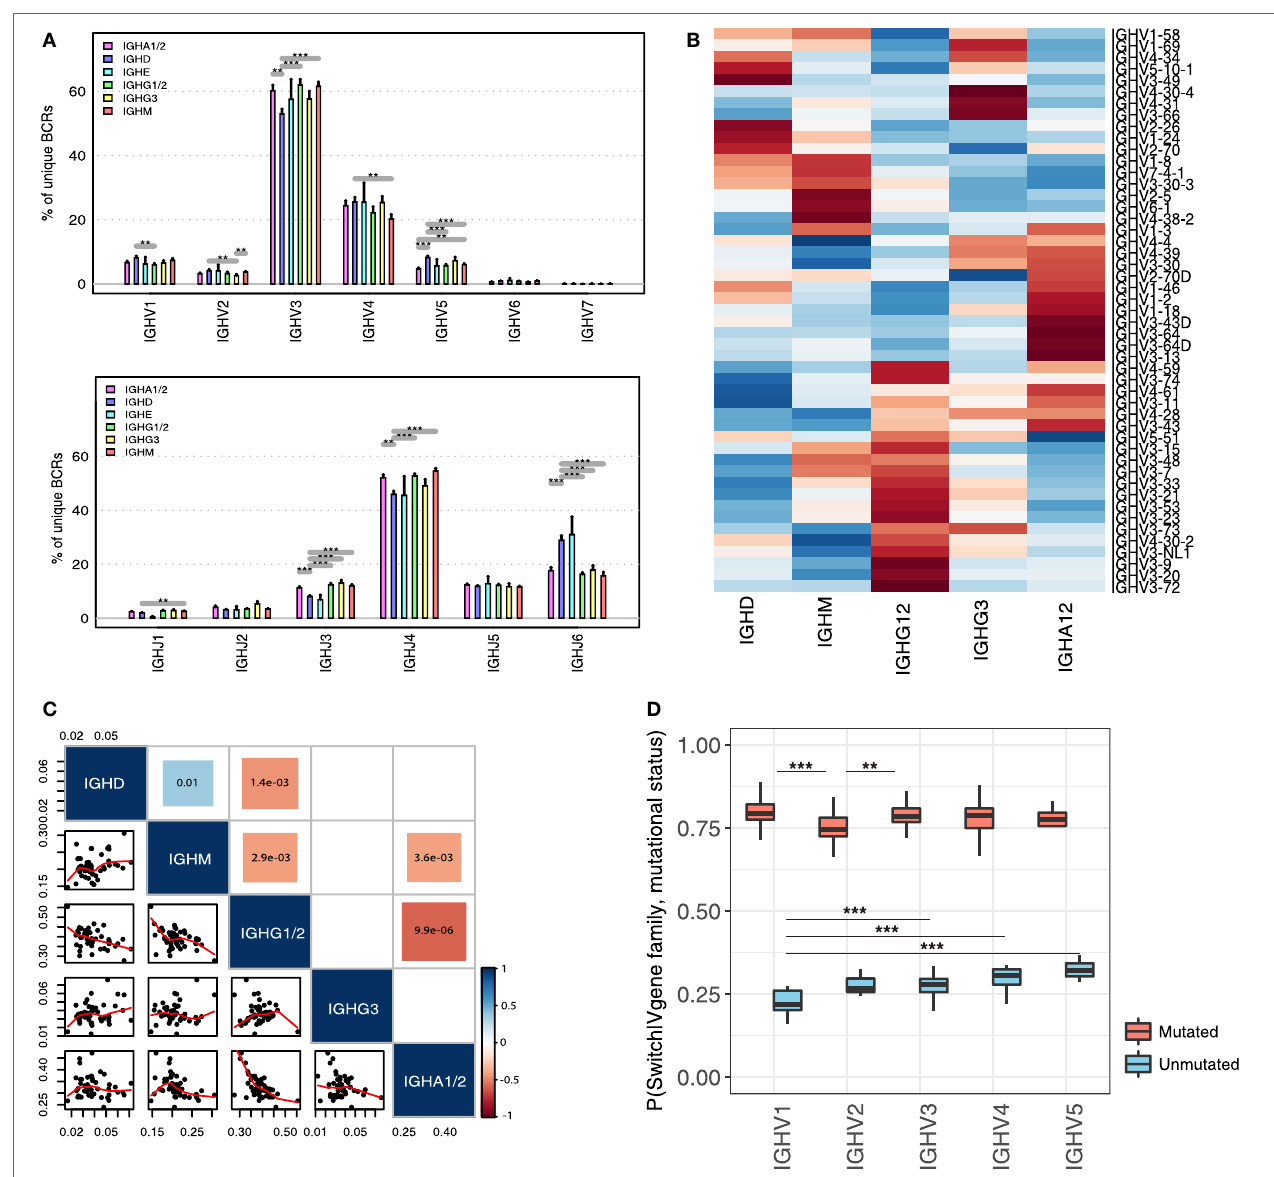
FigUre 5 | Role of somatic hypermutation and variable gene identity in the class-switch fate of healthy B-cell clones. (a) Differences in IGHV (upper panel) and IGHJ (lower panel) gene family usages between different isotype classes in healthy individuals. Frequencies of individual IGHV -J gene families are calculated as percentage of unique B-cell receptor (BCR) reads from each IGHV or IGHJ gene family associated with the respective isotype. (B) Heatmap of IGHV gene frequencies across isotypes. Individual values are scaled by row, key represents row- Z score and distance matrix between IGHV genes was generated using Euclidian distance. Only IGHV genes with > 100 reads were considered. (c) Correlation of IGHV gene frequencies across isotypes. Only unique BCR sequences were considered and IGHV genes represented by less than 100 reads were excluded. The size and the color of the squares represent the absolute value and the direction of the correlation, respectively. The values in the colored squares represent the p -value of the significant positive or negative correlations across isotypes. Blank squares represent non-significant correlations ( p- value > 0.05). The scatterplot matrix represents the frequencies of individual IGHV genes in the respective isotypes. Trendlines are shown in red. (D) Conditional class-switch probabilities of BCRs given in their IGHV gene identity and mutational status. Boxplots represent the variance of conditional probabilities of individual IGHV genes from the respective IGHV gene families. Only IGHV genes with > 100 reads in both mutated and unmutated state were considered. *** p -value < 0.0005; ** p -value < 0.001; and * p -value < 0.05 (Wilcoxon rank-sum